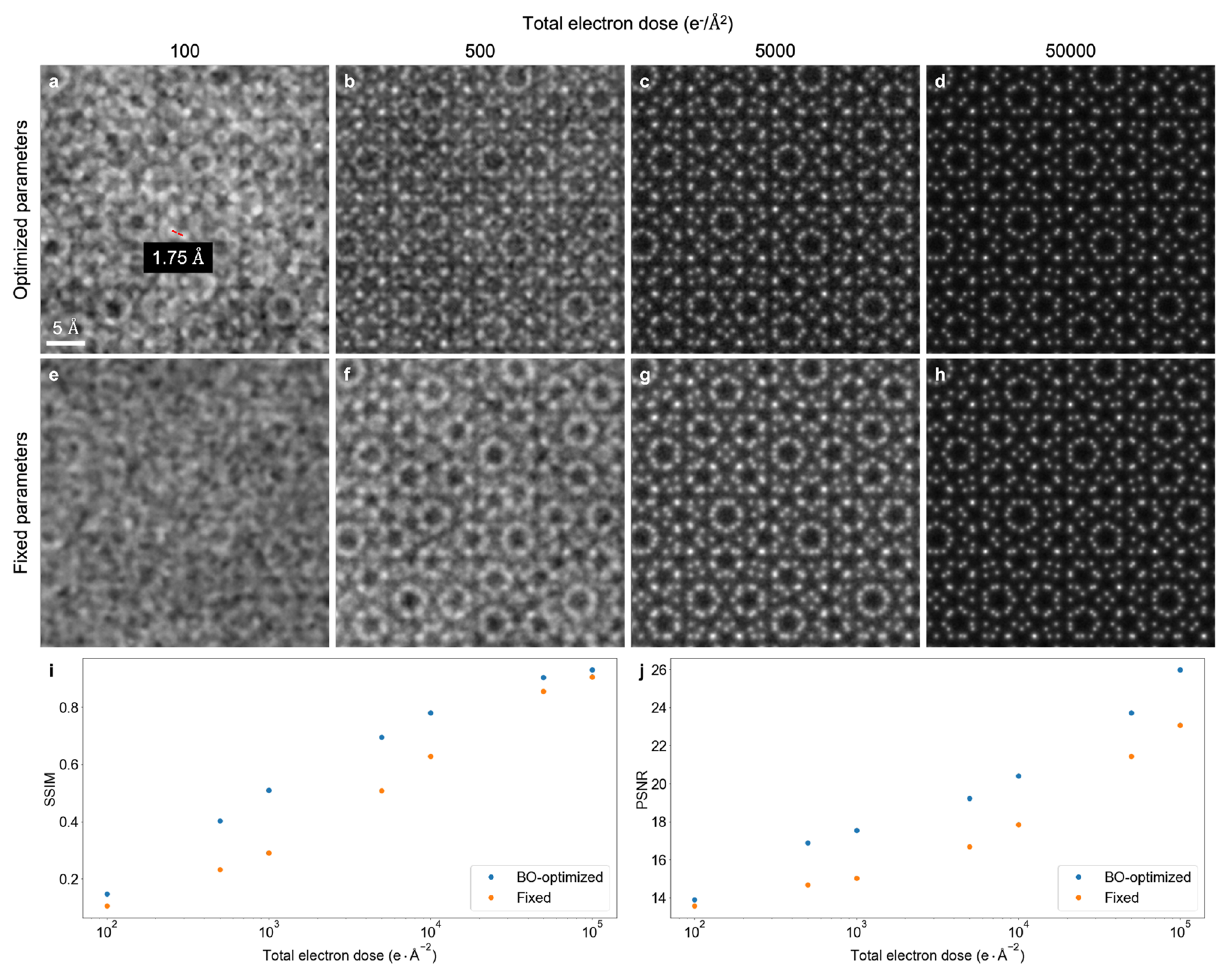
Figure 5. Ptychographic reconstructions of simulated bilayer MoS 2 at different total electron doses with an optimized set of experimental parameters compared with an expert-chosen set. ( a – d ) Phase of the reconstructed objects using experimental parameters that are optimized by Bayesian optimization. ( e – h ) Reconstructions using a fixed set of experimental parameters that are similar to ref. 16 . ( i , j ) SSIM and PSNR of reconstructions at different dose levels,